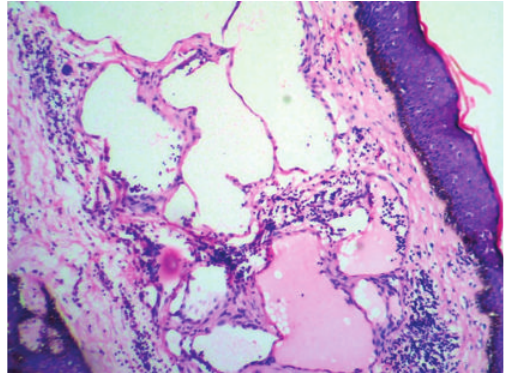
Figure 2: Irregular thin-walled vascular channels of variable sizes in the dermis. Lymphocytes are seen within and outside the lumen (Case 1—H&E × 100).